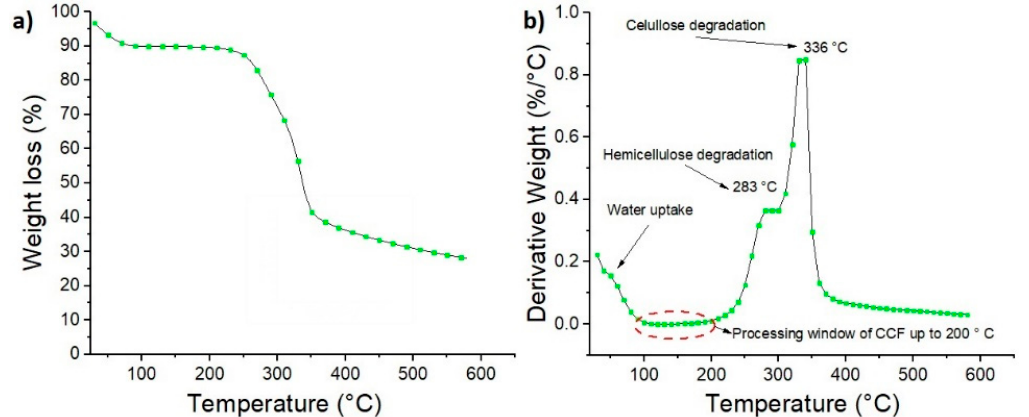
Figure 5. ( a ) TG and ( b ) DTG curves of coir coconut fibers at a heating rate of 10 °C/min.